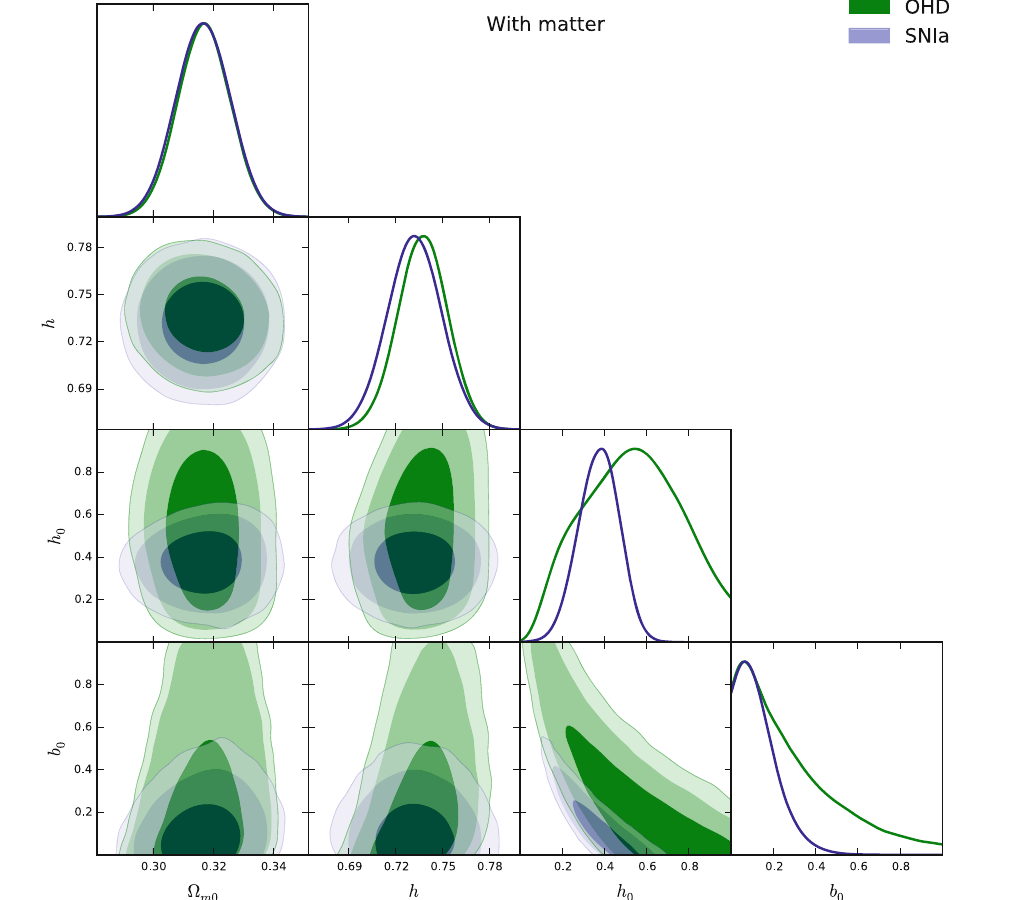
Fig. 11 1D marginalized posterior distributions and the 2D 68 , 95 , 99 . 7% confidence levels for the (cid:19) m 0 , h , h 0 , and b 0 parameters of the NED cosmology including dust matter obtained from OHD and SNIa